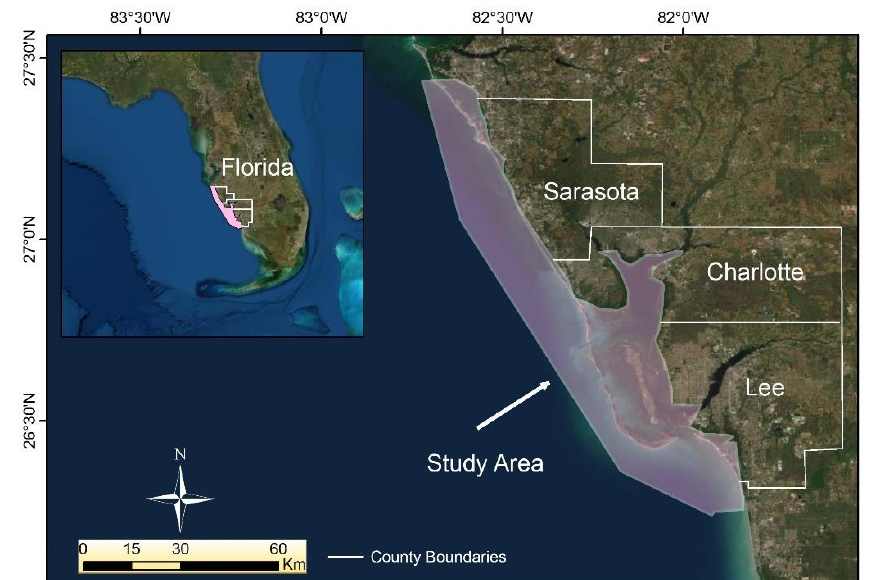
Figure 1. Location map for the study area covering coastal waters (width: ~10–60 km; length: 180 km) of Charlotte County in southwest Florida.